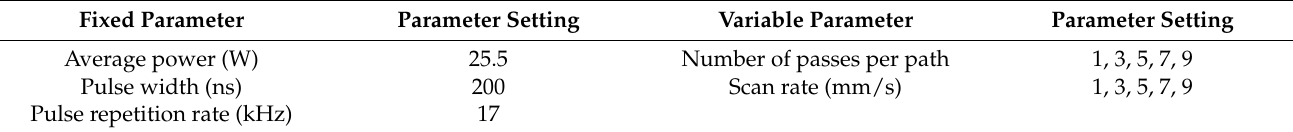
Table 3. Operating parameters for testing the effects of number of passes per path and scan rate on the PCD kerf depth. Fixed